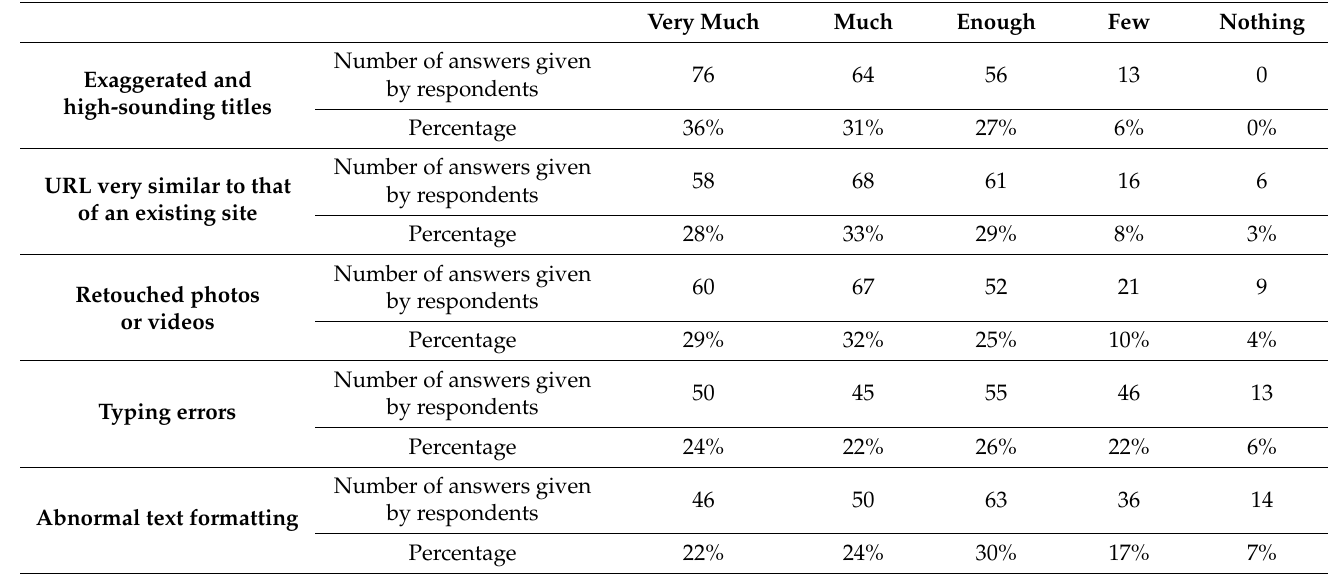
Table 8. Elements characterizing false